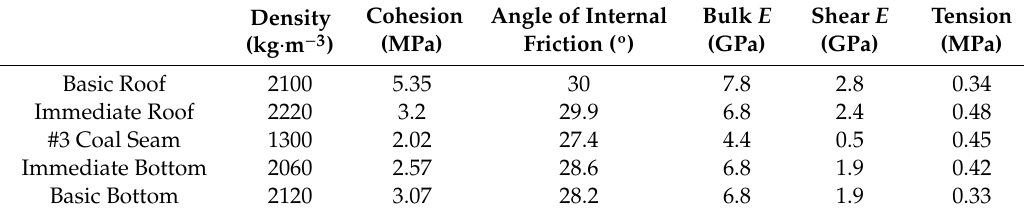
Table 1. Physical and mechanical parameters of rock.